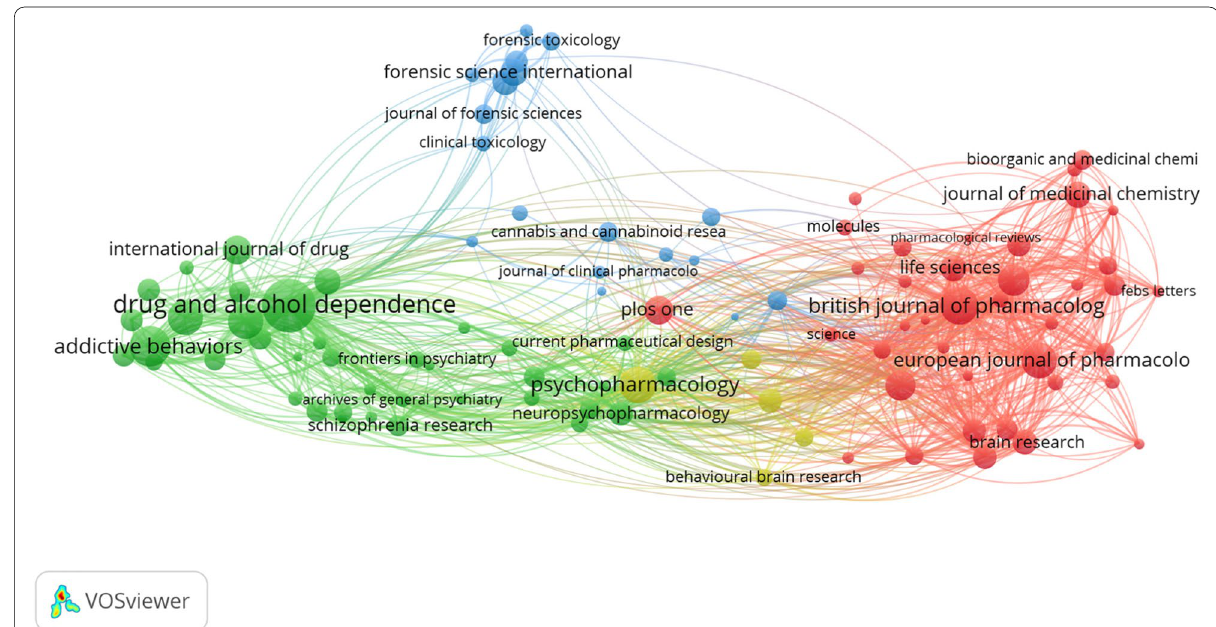
Fig. 2 Citation analysis of the 100 journals publishing the largest number of cannabis and cannabinoid publications. Journals with a higher total number of citations on publications are depicted using larger nodes and larger text. The VOSviewer software was used to generate the bibliometric